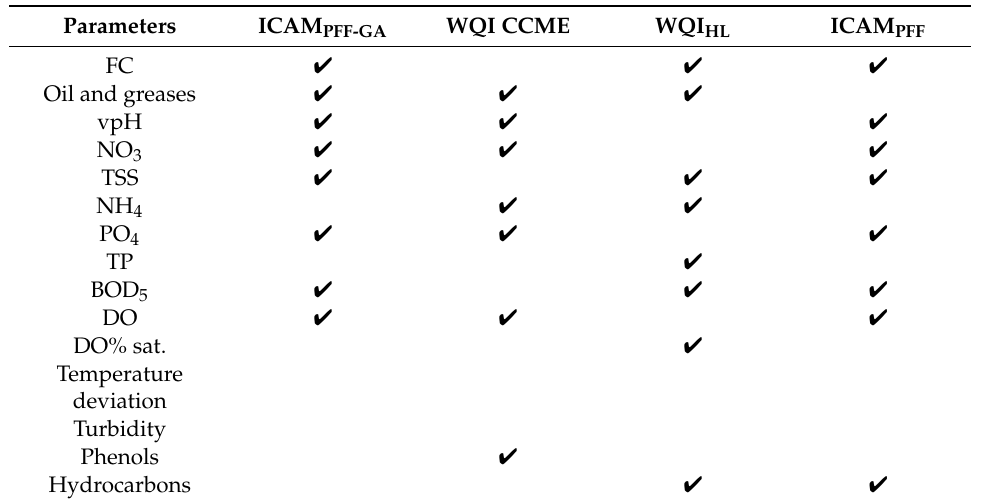
Table 7. Physicochemical parameters considered in the quality